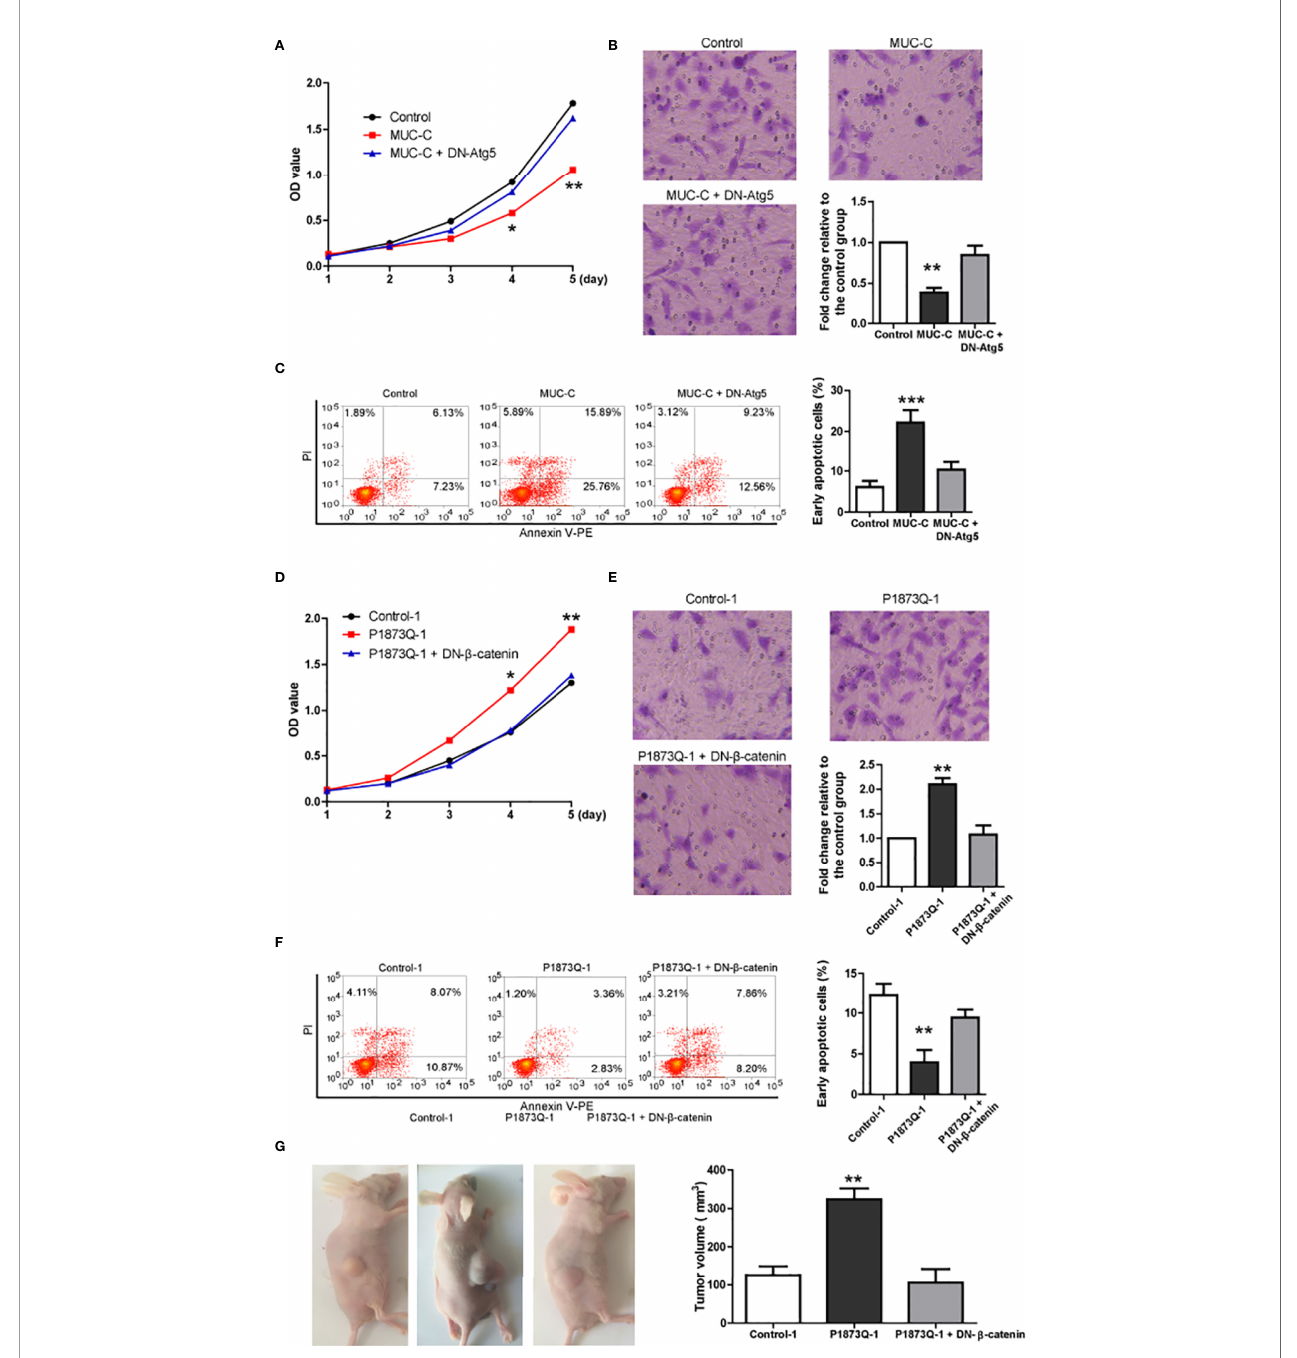
FIGURE 7 | MUC6-autophagy- b -catenin regulates tumor behaviors in in-vitro assays. (A) MTT assay showing the proliferation of WiT49 cell infected with indicated vectors. (B) Transwell invasion assay showing the invasion of WiT49 cell infected with indicated vectors. (C) Annexin V apoptosis assay showing the apoptosis of WiT49 cell infected with indicated vectors. (D) MTT assay showing the proliferation of one clone from isogenic control cell and P1873Q mutant WiT49 cell, respectively. (E) Transwell invasion assay showing the invasion of one clone from isogenic control cell and P1873Q mutant WiT49 cell, respectively. (F) Annexin V apoptosis assay showing the apoptosis of one clone from isogenic control cell and P1873Q mutant WiT49 cell, respectively. For all, *P<0.05; **P<0.01; ***P<0.001. (G) Representative images of xenografted model and quanti fi cation of tumor size of three groups: isogenic control WiT49 cell (n=5), MUC6 P1873Q mutant WiT49 cell (n=5) and MUC6 P1873Q mutant WiT49 cell plus DN- b -catenin (n=5).